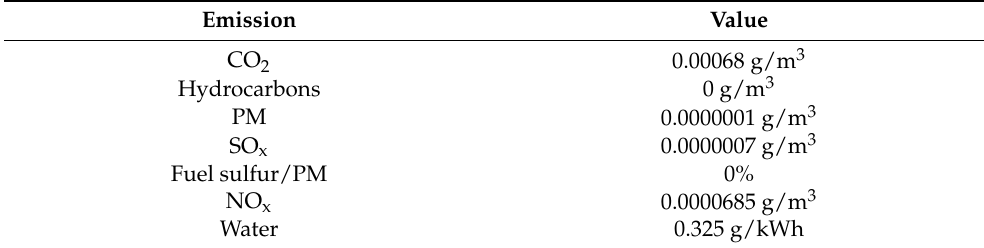
Table A10. DFC300 fuel cell emissions [40].